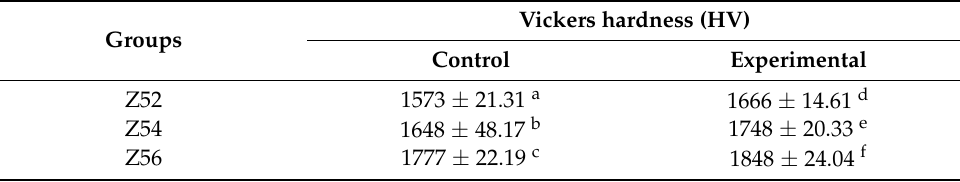
Table 4. Vickers hardness of printed zirconia; different letters represent significant differences ( p <